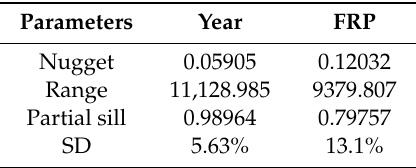
Table 1. Result of the semivariogram parameters.